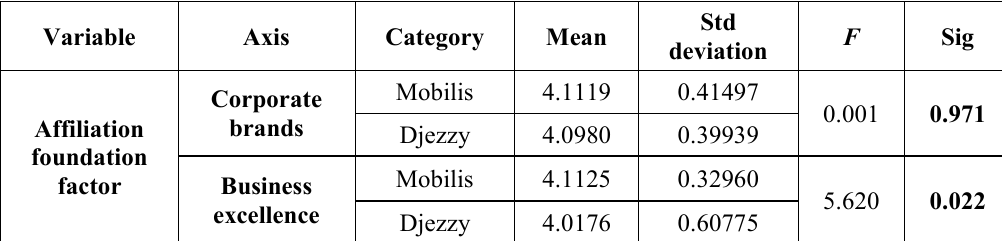
Table 7. The Results of T -Test of Two Independent Samples